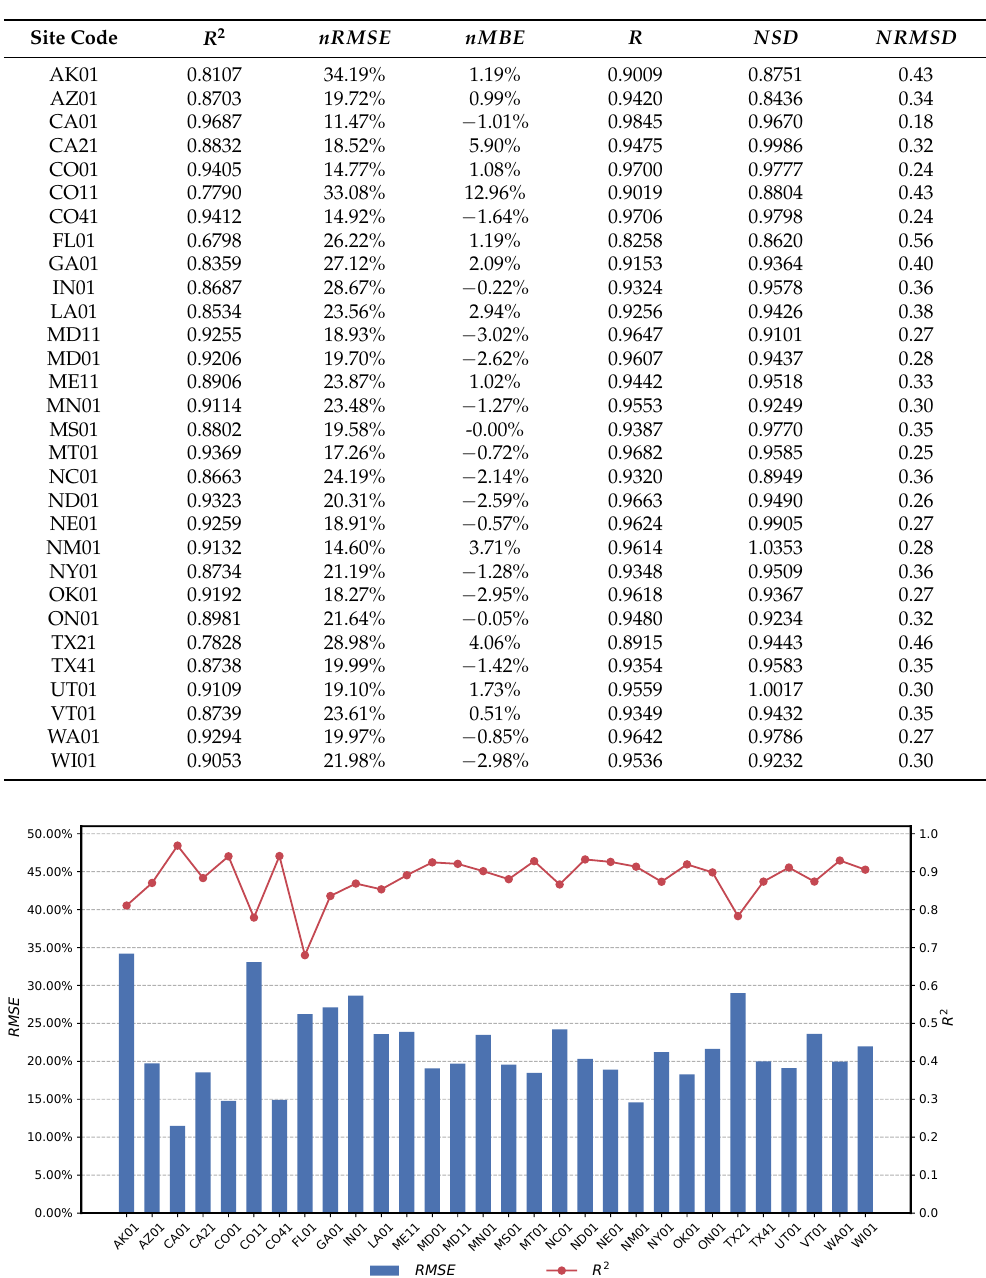
Table 7. Performance evaluation of the DRFCN+RF model on the UVMRP dataset by R 2 , nRMSE , nMBE , R , NSD , and NRMSD .